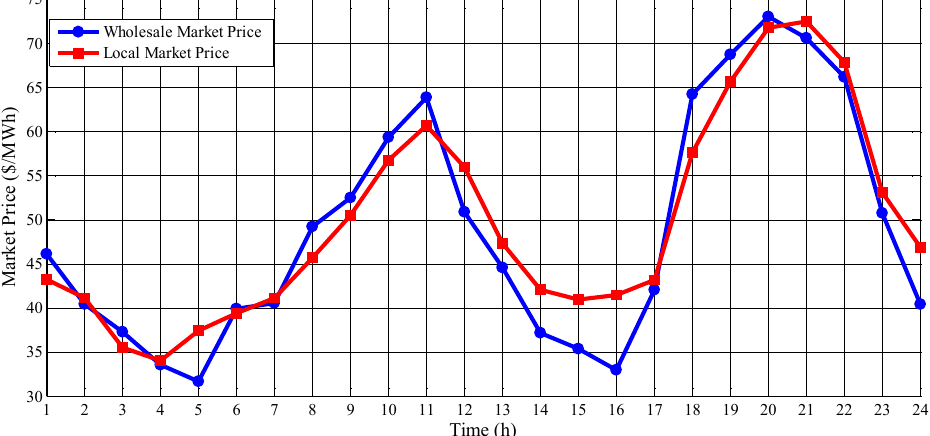
Figure 7. Day-Ahead (DA) market prices forecast.